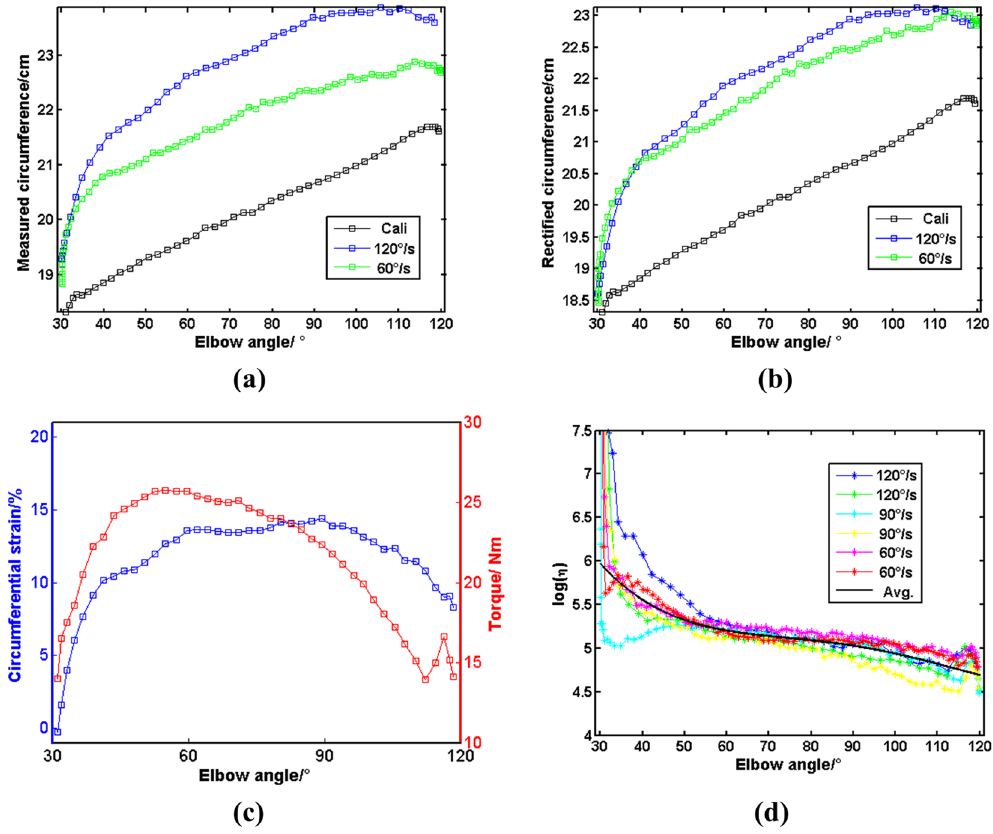
Figure 3. ( a ) Measured circumference; ( b ) Rectified circumference; ( c ) Typical circumferential strain and torque during isokinetic flexion (90°/s); ( d ) η lg in isokinetic test. All are from Subject No. 1 in isokinetic tests.